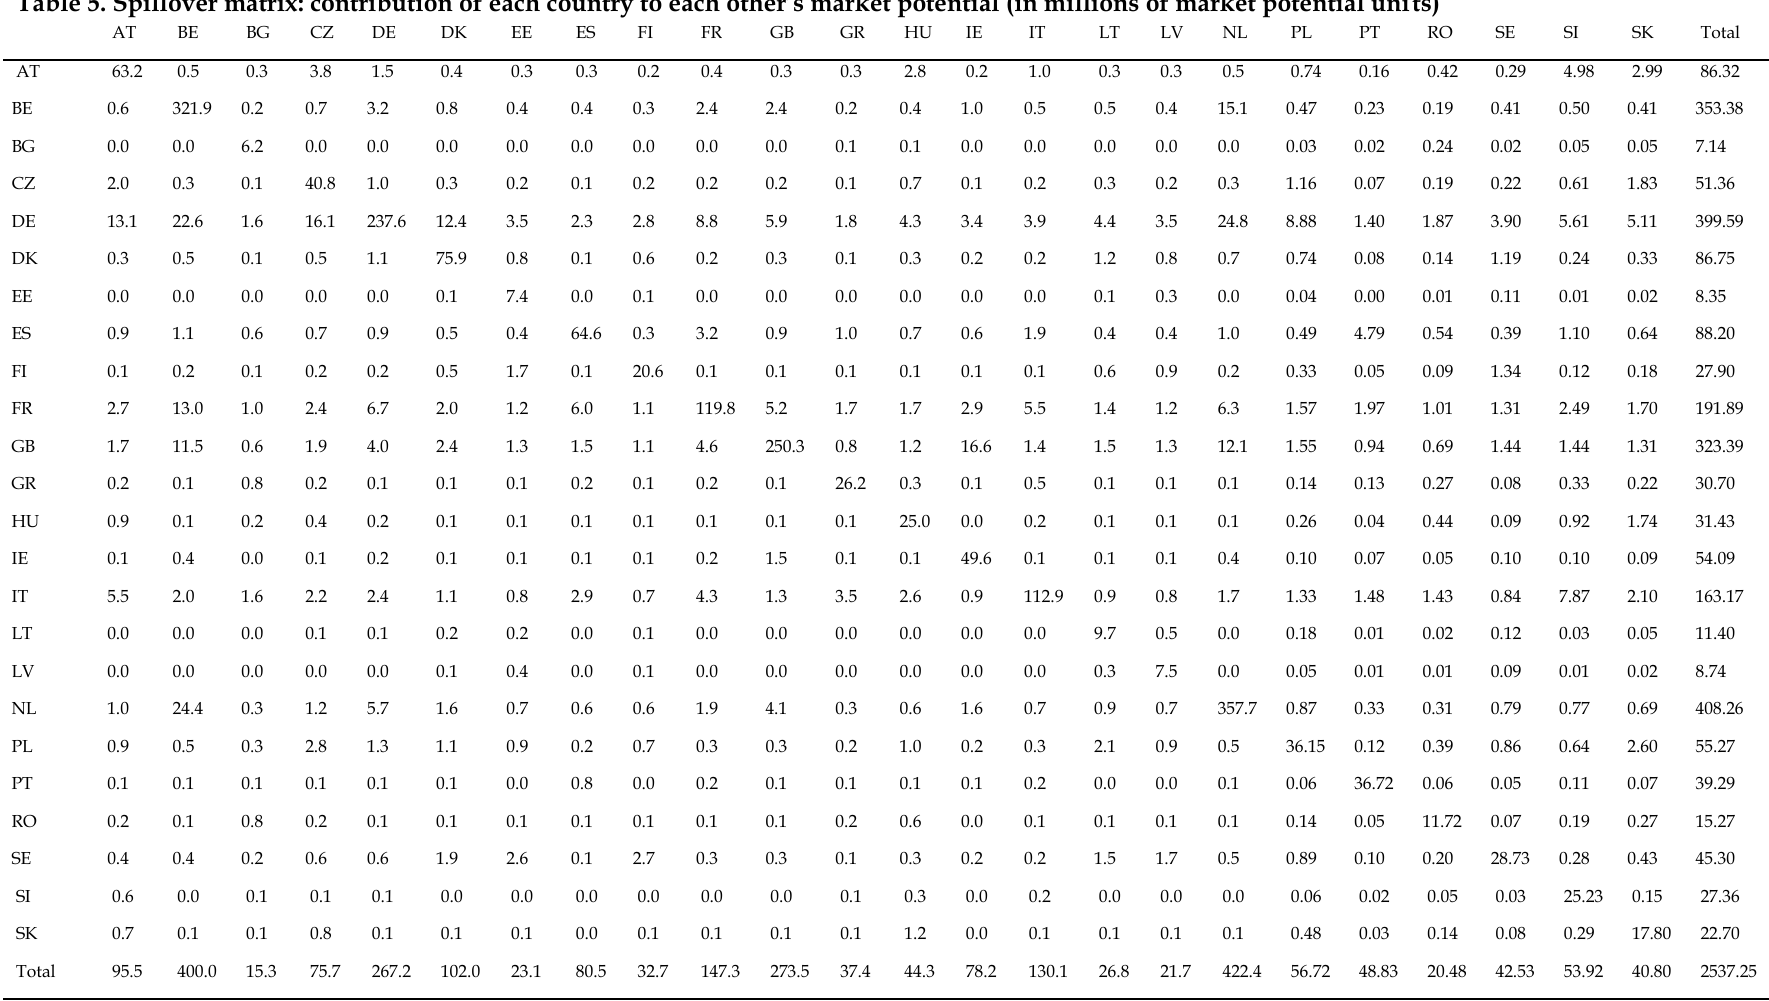
Table 5. Spillover matrix: contribution of each country to each other’s market potential (in millions of market potential